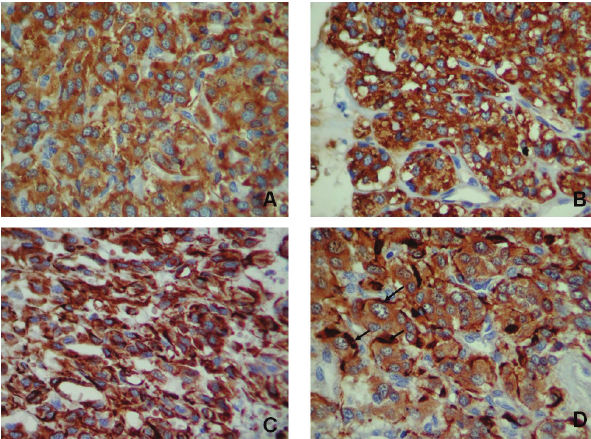
Figure 5 - Immunohistochemical findings. Diffuse positivity for chromogra- nin (A), synaptophysin (B), and vimentin (C), and focal positivity for S-100 protein in sustentacular cells (D, arrows).